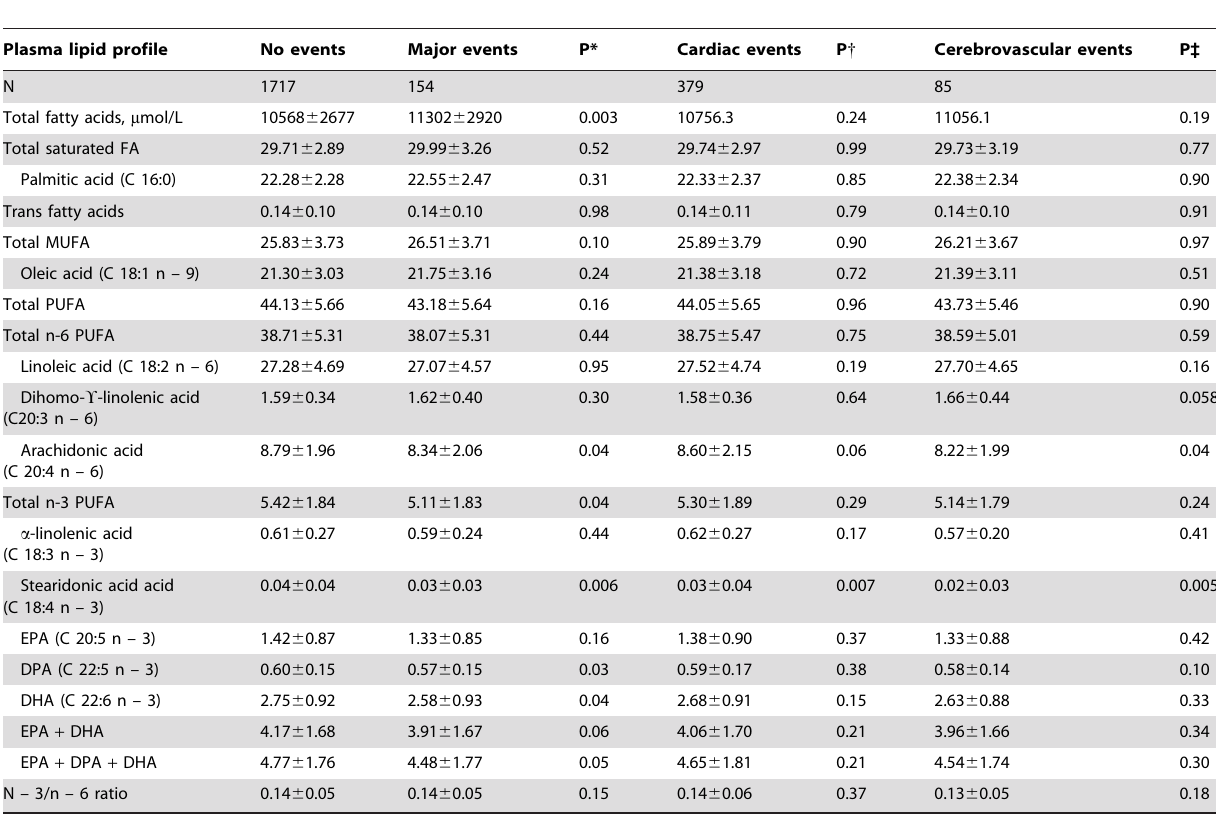
Table 2. Baseline plasma lipid profile of SU.FOL.OM3 participants without and with major events, cardiac and cerebrovascular events at the end of the